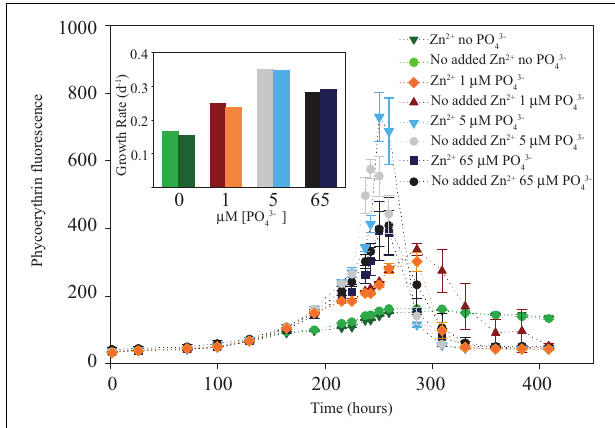
FIGURE 1 | Phycoerythrin fluorescence vs. time, chronic PO 43 −